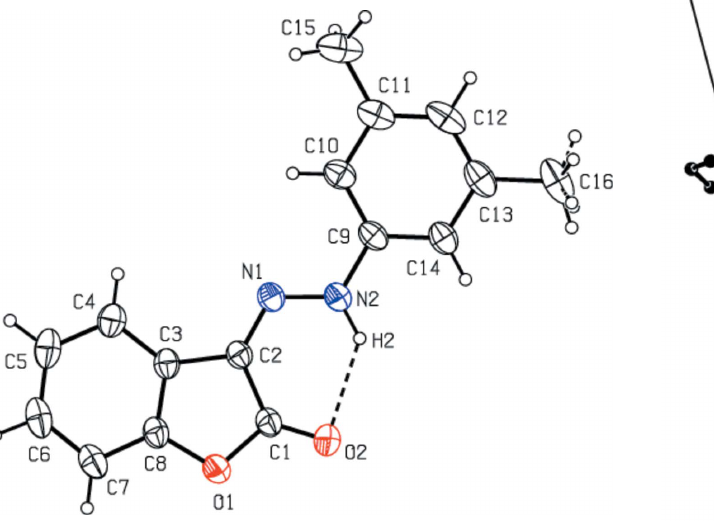
Figure 3 A partial packing view of the title compound, showing the (cid:2) – (cid:2) stacking interactions (dashed lines). Only N-bound H atoms are shown for clarity [Symmetry codes: (ii) (cid:4) x + 1, (cid:4) y + 1, (cid:4) z + 1; (iii) 2 (cid:4) x , 1 (cid:4) y , 2 (cid:4) z